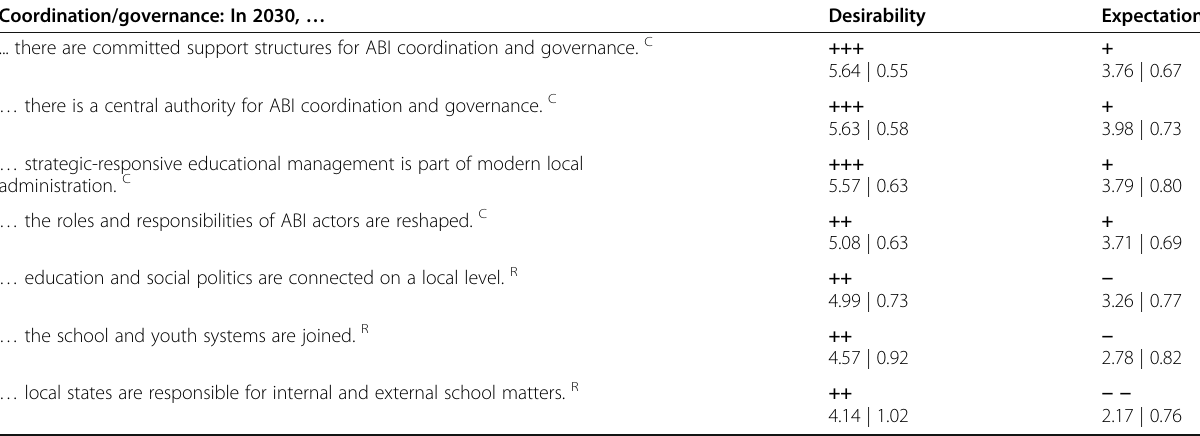
Table 8 Means and standard deviations of statements on coordination and governance in ABIs Coordination/governance: In 2030,